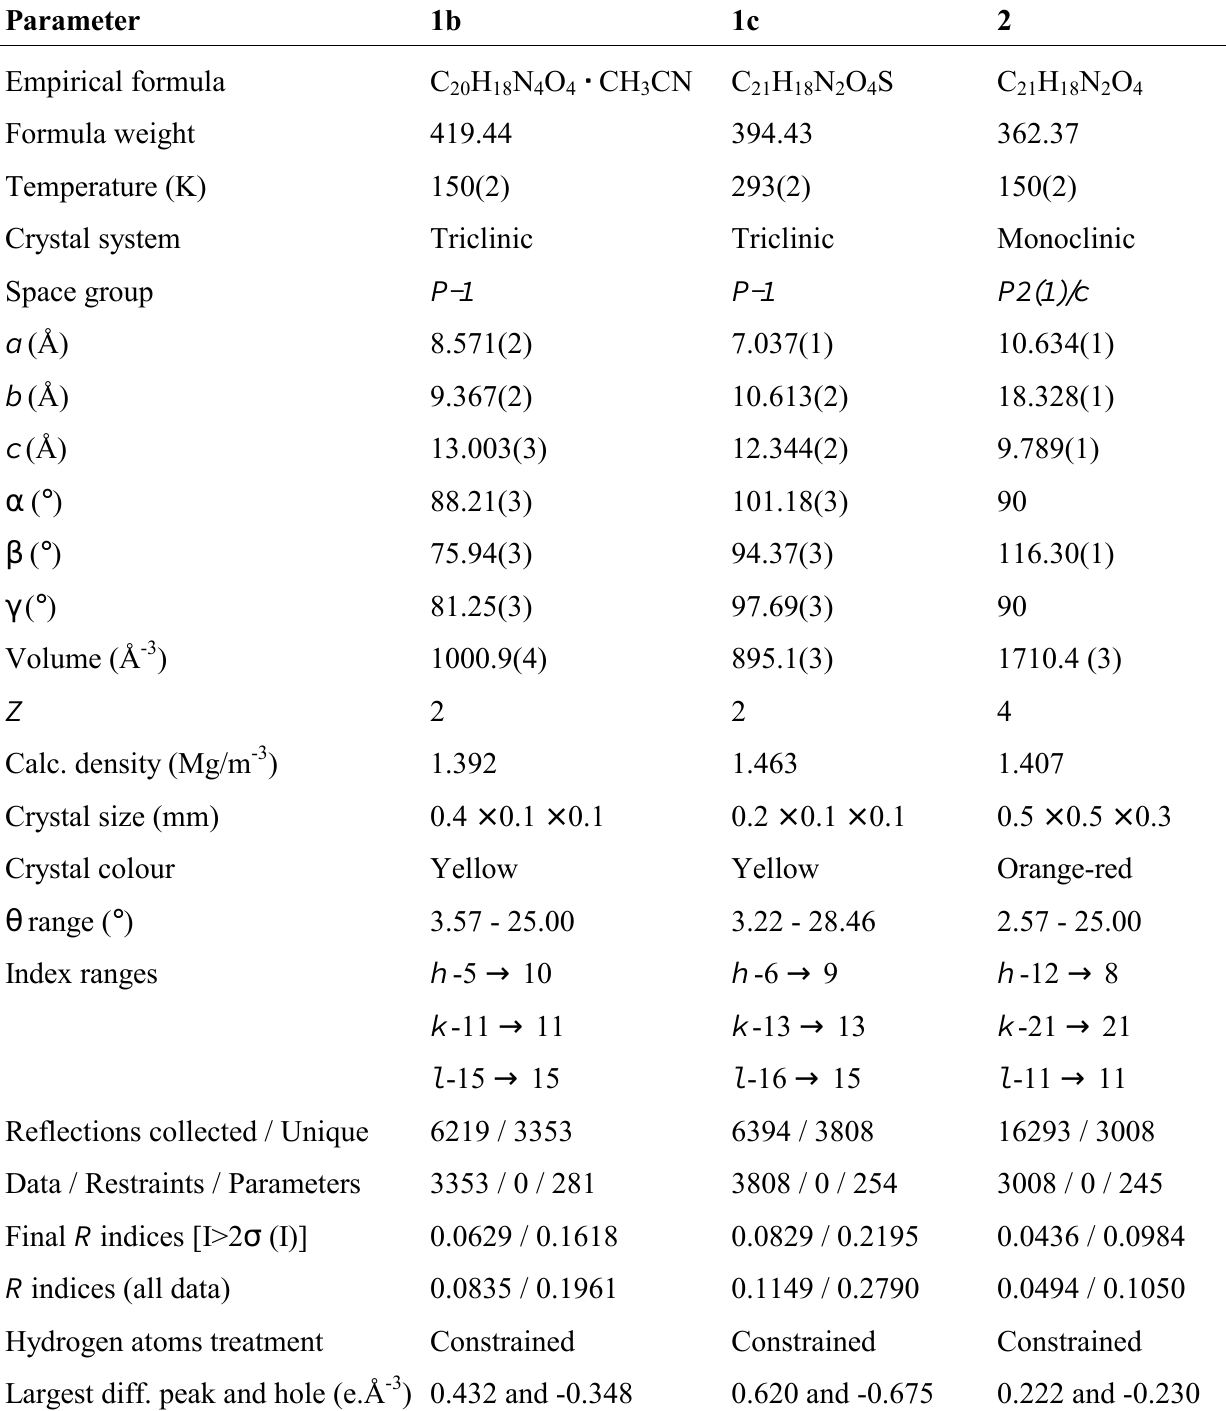
Table 1. Crystal data of the compounds 1b , 1c , and